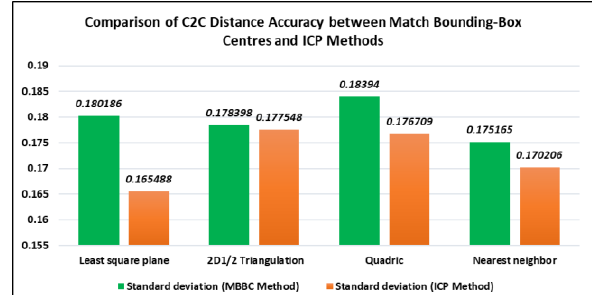
Figure 31. The comparison of C2C distance accuracy between MBBC and ICP registration